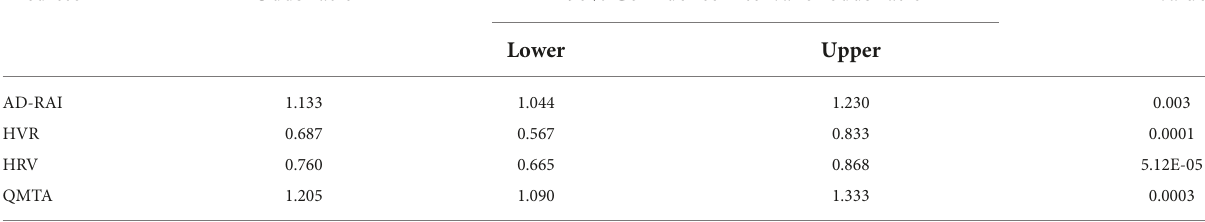
TABLE 3 Results of the logistic regressions for AD-RAI, HVR, HRV and QMTA. Predictor* Odds ratio 95% Confidence interval of odds ratio P -value Lower Upper AD-RAI 1.133 1.044 1.230 0.003 HVR 0.687 0.567 0.833 0.0001 HRV 0.760 0.665 QMTA